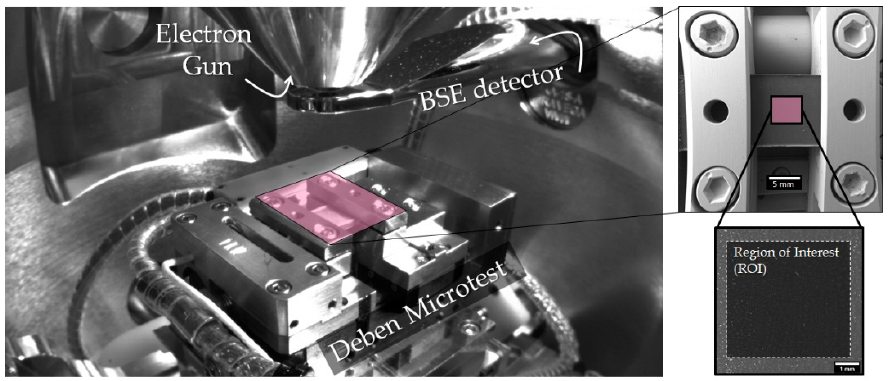
Figure 4. The typical illustration of in situ tensile test with the used Region of Interest (ROI) for DIC analysis.